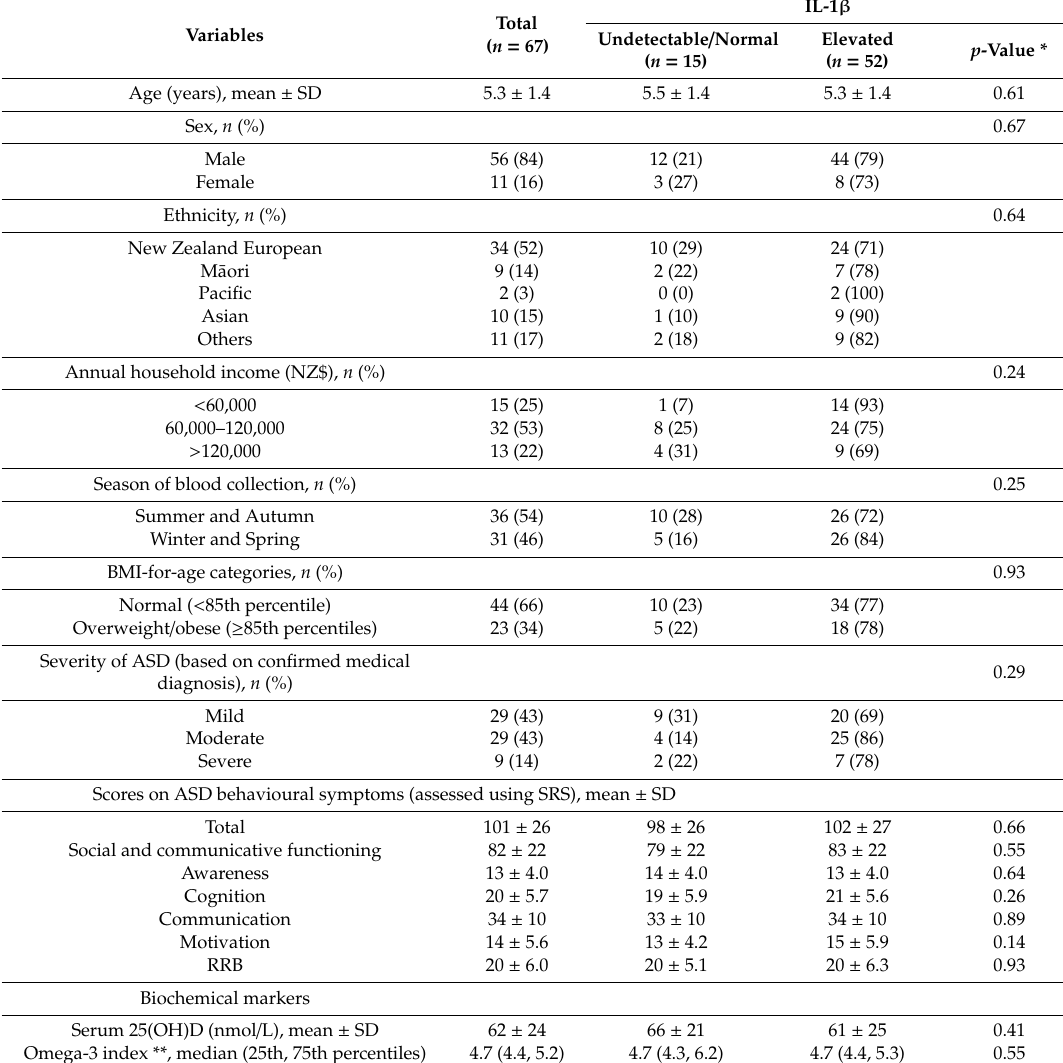
Table 2. The relationship of interleukin 1 beta (IL-1 β ) with biochemical markers and behaviours in 67 children with autism spectrum disorder